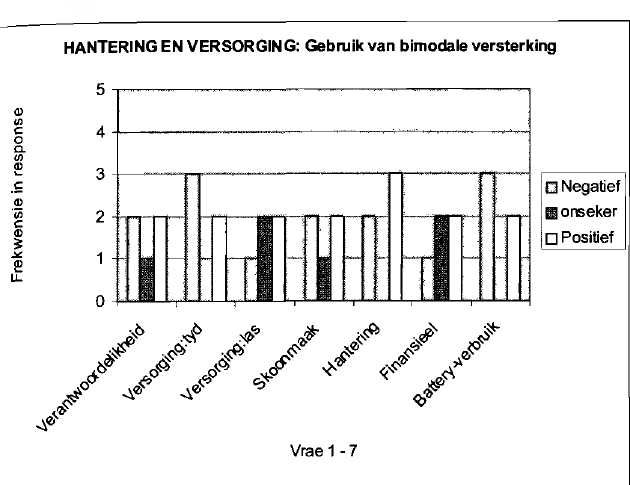
Figuur 4a: Deelnemers se ervarings aangaande die gebruik van slegs die kogleere inplanting in terme van hantering en versorging.